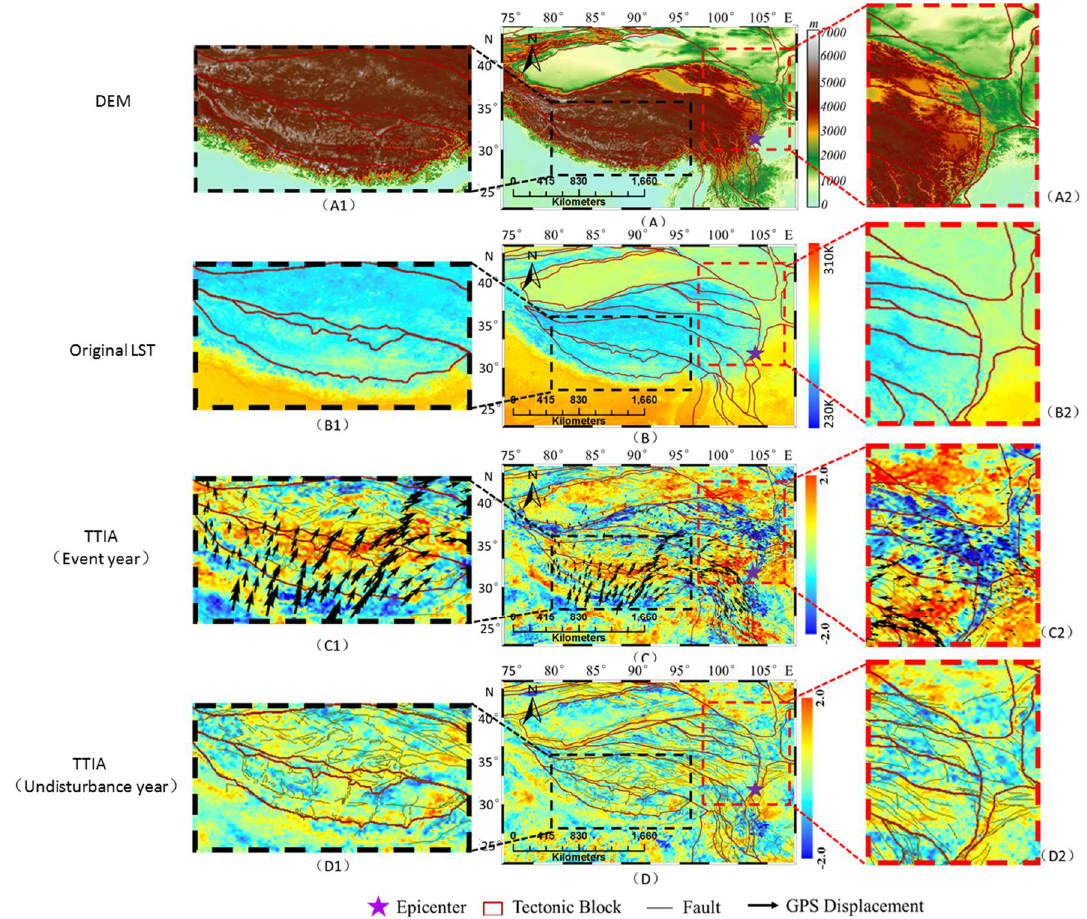
Figure 23. Presentation of the DEM, original MODIS LST data, and TIR anomalies based on the TTIA method and GPS displacement data on the Tibet-plateau area.